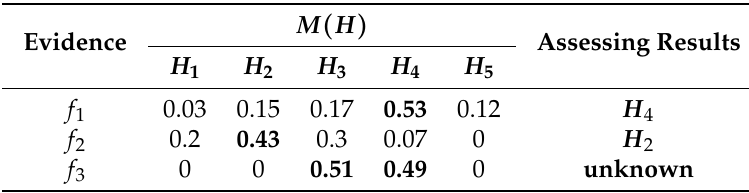
Table 6. Basic probability assignment.